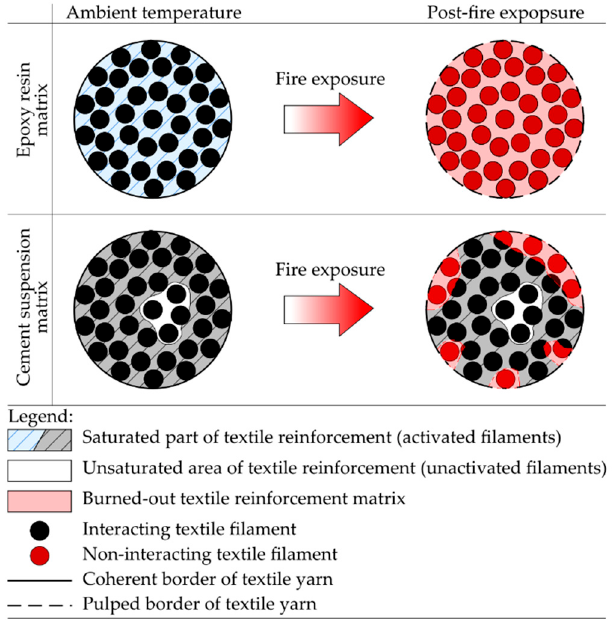
Figure 10. Schematic description of the fire exposure influence to a different type of textile reinforcement matrix.